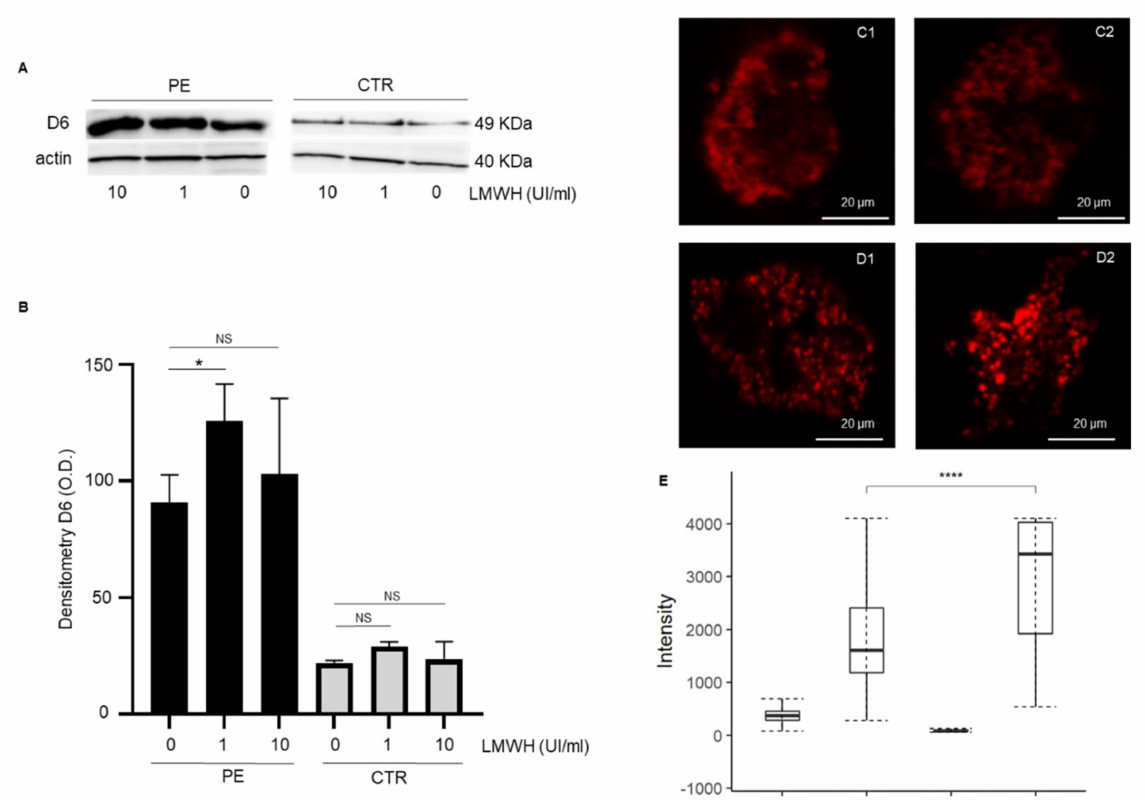
Figure 1. ( A ) Representative immunoblotting showing expression of D6 receptor in trophoblast cell lysates from PE or controls in basal conditions (0) and after incubation with LMWH for 24 h (1 and 10 UI/mL). ( B ) Quantitative analysis of Western blot results shows higher expression of D6 receptor in trophoblast cells from preeclamptic women ( n = 3) after incubation with enoxaparin for 24 h (1 UI/mL) compared to basal conditions (0). No significant differences in terms of D6 expression were observed in trophoblast cells from normal pregnancy (CTR, n = 3) with or without LMWH treatment. ( C – E ) Confocal analysis of trophoblast cells showed a basal higher expression of D6 in preeclamptic women ( n = 9) compared to controls ( n = 9) and a significant increase of D6 expression in PE after cells incubation with LMWH (10 UI/mL) for 24 h. Data are expressed as the mean ± standard error (SE). PE: preeclampsia; CTR: control; LMWH: low molecular weight heparin; NS: not